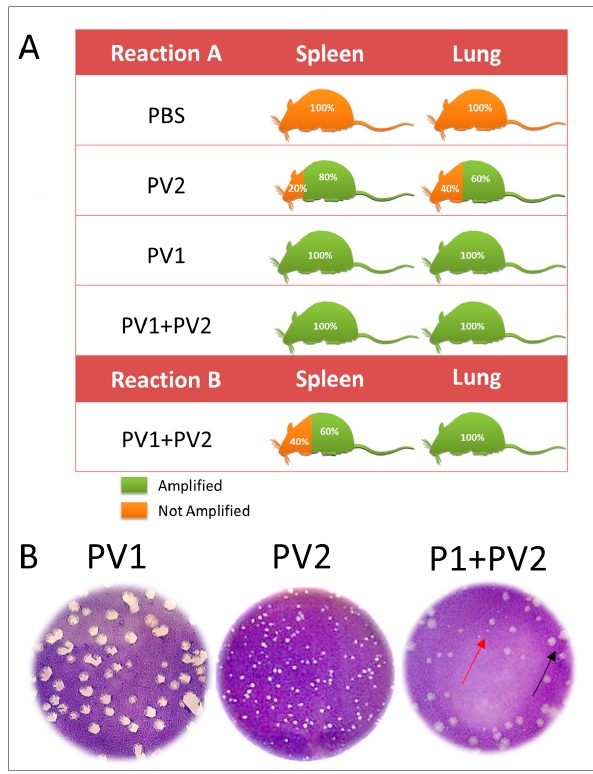
Figure 4. Detection of VAC-BR GI and GII in infected Balb/C mice: ( A ) qPCR detection of viral DNA from VACV A56R gene in mice spleen and lung samples. The results of Reaction A and Reaction B are represented. ( B ) Plaque phenotype assays of monoinfected (PV1-GII and PV2-GI) and coinfected mice showed two viral populations: small plaques-PV2 (red arrows) and large plaques-PV1 (black arrows). PV1-GII: Pelotas virus 1; PV2-GI: Pelotas virus 2; PBS: phosphate-buffered saline.